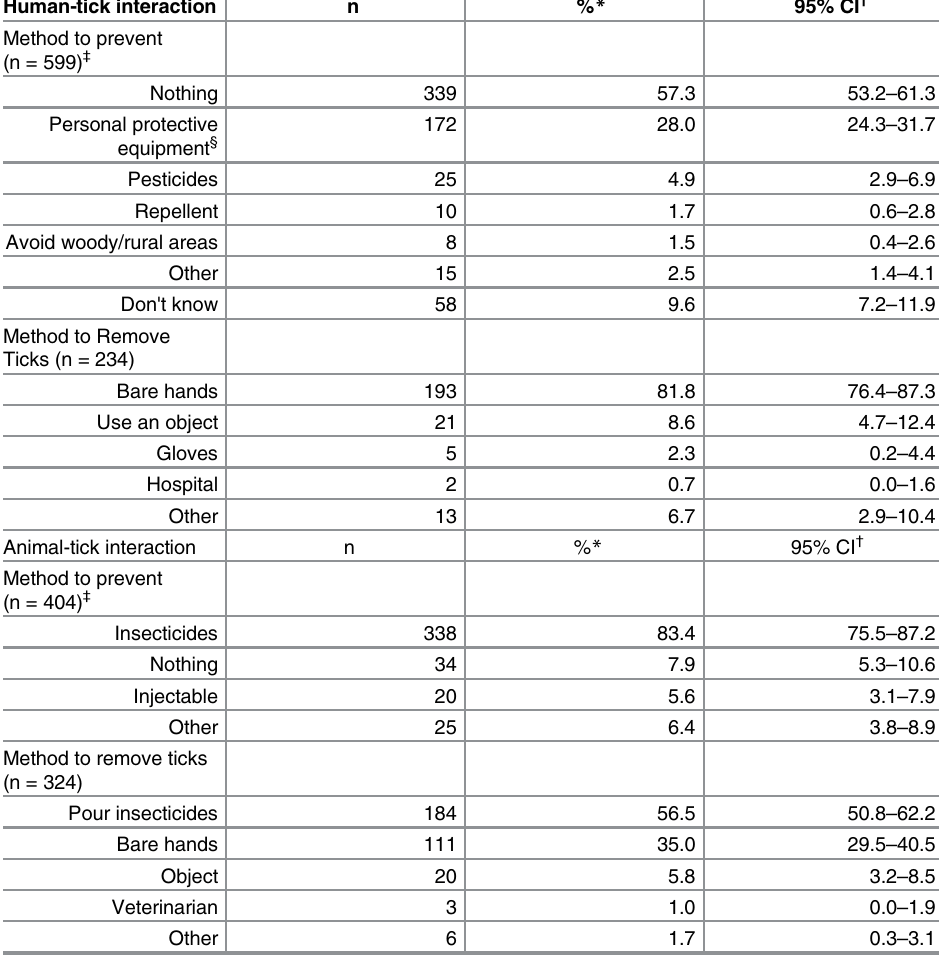
Table 5. Tick prevention and removal practices among survey participants during an investigation of the 12 rural villages reporting at least one 2014 Crimean-Congo hemorrhagic fever case from January to September 2014 in